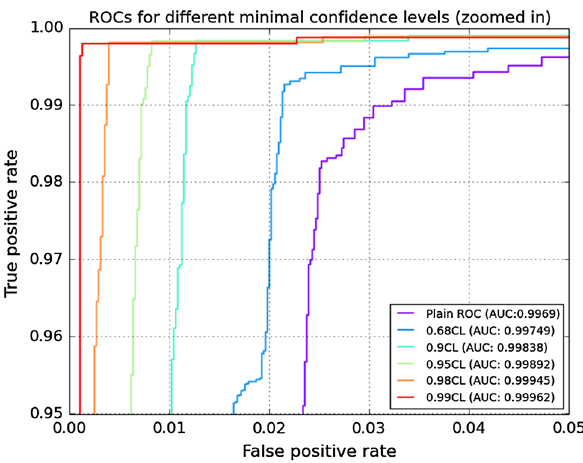
Fig. 9 Several ROCs for the pMSSM-trained classifier with varying CL cuts when tested on the natural SUSY sample